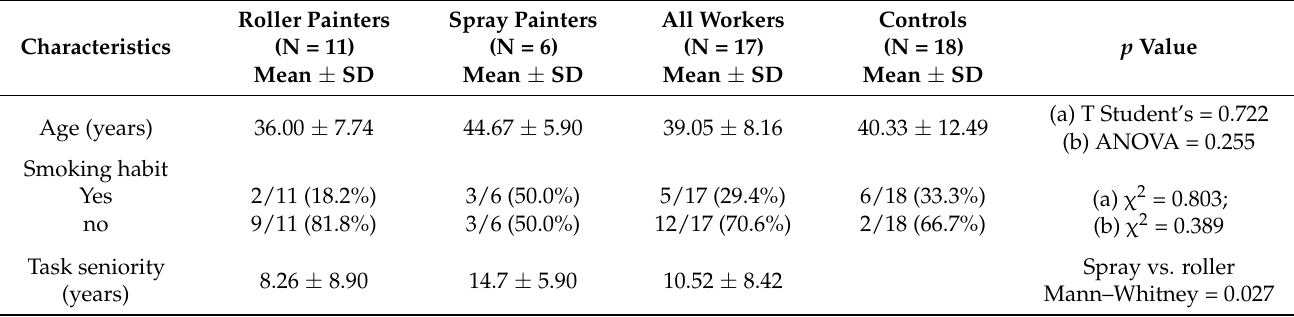
Table 1. Characteristics of the studied populations.